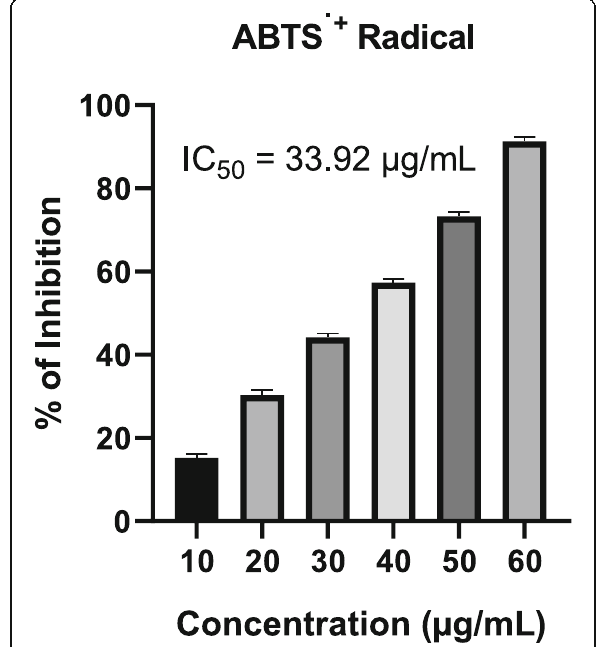
Fig. 3 ABTS ● + radical cation scavenging activity of root extract of S. heyneanus. Statistical significance, t = − 88.094 and p